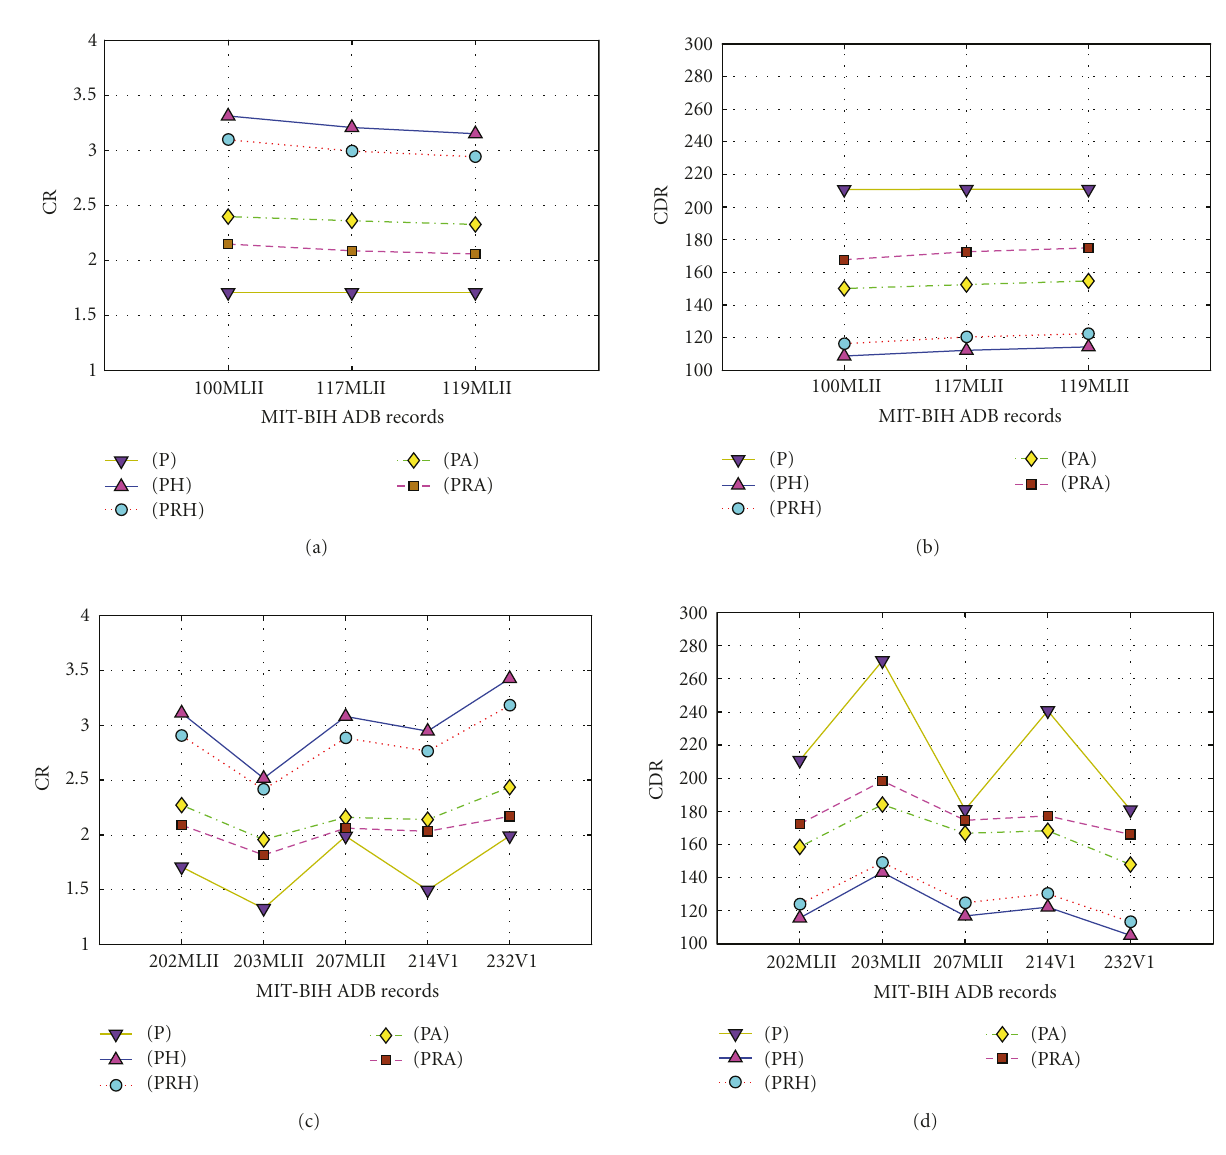
Figure 8: Compression e ffi ciency performance results for di ff erent compression schemes: (a) CR and (b) CDR using ABT on long-duration dataset, (c) CR and (d) CDR using SBT on short-duration